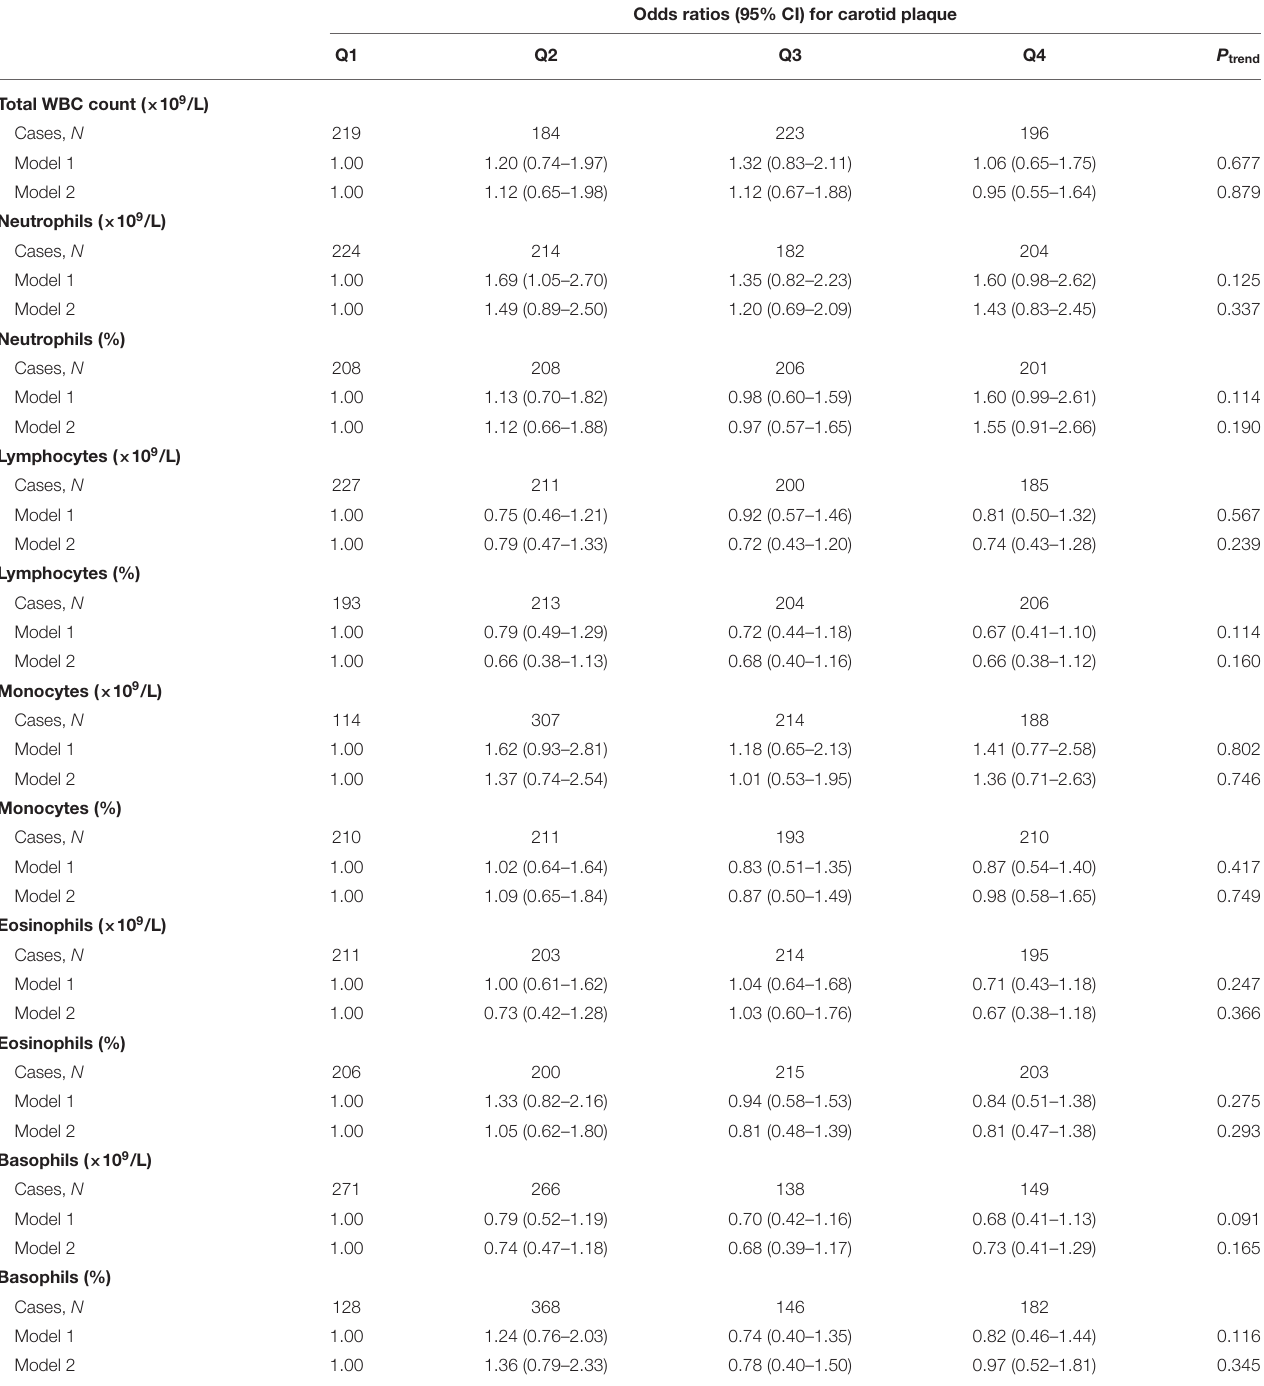
TABLE 3 | Odds ratios and 95% CI for carotid artery plaque by quartiles of total white blood cell (WBC) and differential WBC counts for women. Odds ratios (95% CI) for carotid